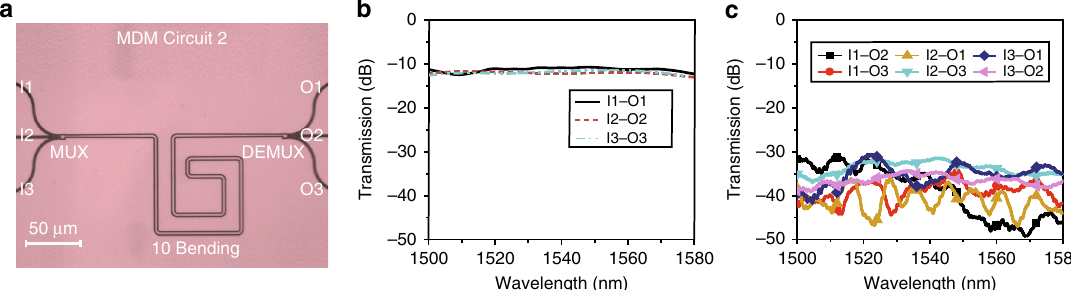
Fig. 6 Fabrication and experimental demonstration of the mode-division multiplexing (MDM) circuit 2. a The top-view microscope image of the MDM circuit 2 consists of a multiplexer, 10 bends, and a demultiplexer. b The measured insertion losses for different input/output ports. c The measured crosstalk performances for different input/output